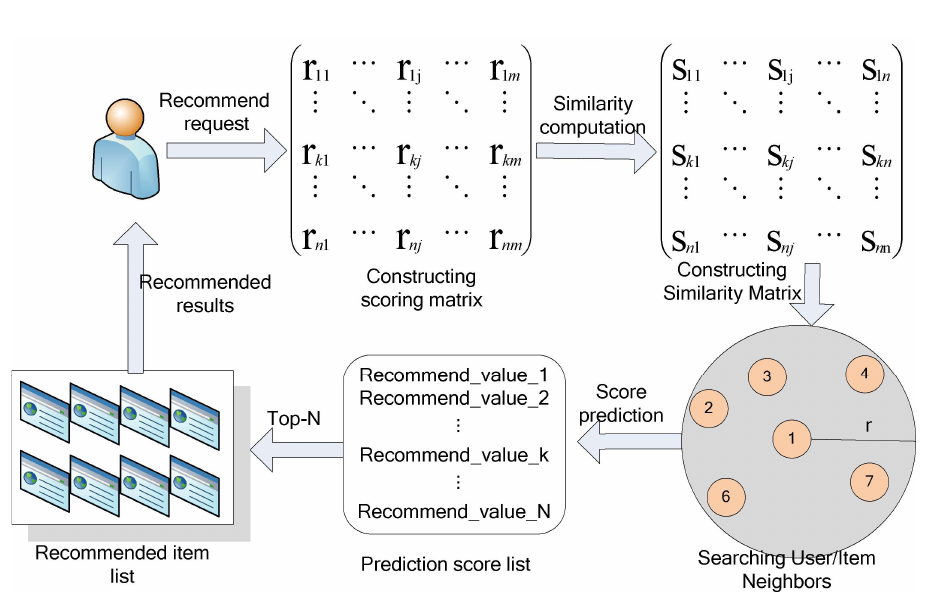
Figure 1. General recommendation process of collaborative filtering algorithm.